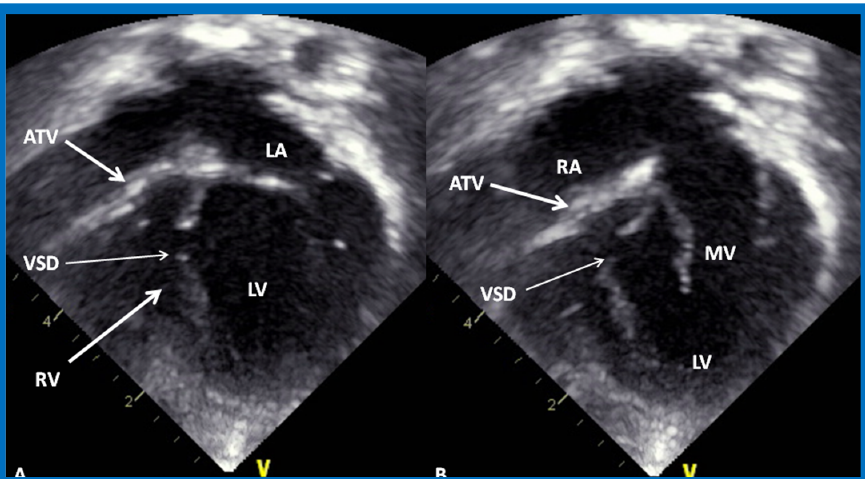
Figure 17. Selected video frames from apical four-chamber, 2-dimensional echocardiographic views of a neonate with tricuspid atresia showing an enlarged left ventricle (LV), a small right ventricle (RV) and a dense band of echoes at the site where the tricuspid valve echo should be (ATV) (thick arrow) with closed ( A ) and open ( B ) mitral valve. A moderate sized ventricular septal defect (VSD) (thin arrows) is shown. LA, Left atrium; RA, Right atrium. Reproduced from Rao P.S. [39].